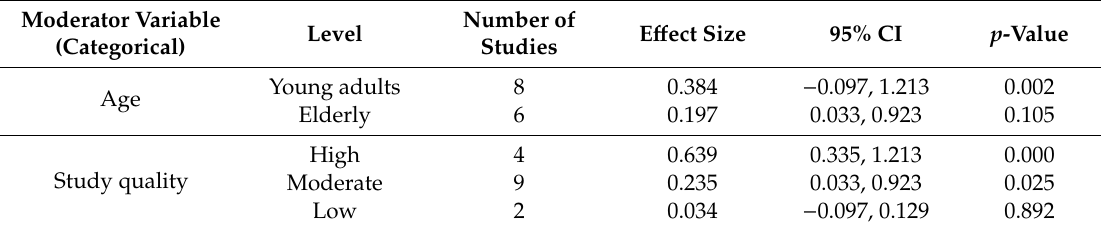
Table 4. Moderator analysis for OSE versus